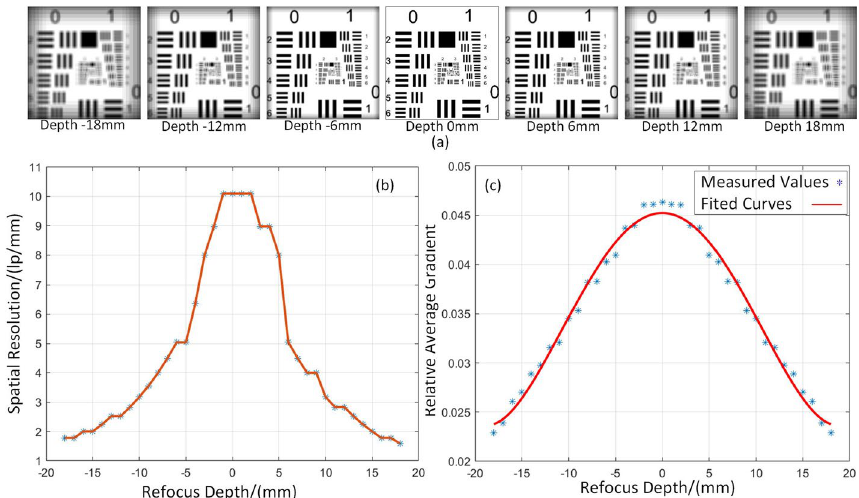
Fig. 10 The evaluations of refocused images at different depths, a some of the refocused images at different depths, b the spatial resolution measured by the USAF1951 of the refocused images, c the relative average gradient of the refocused images and the fitted